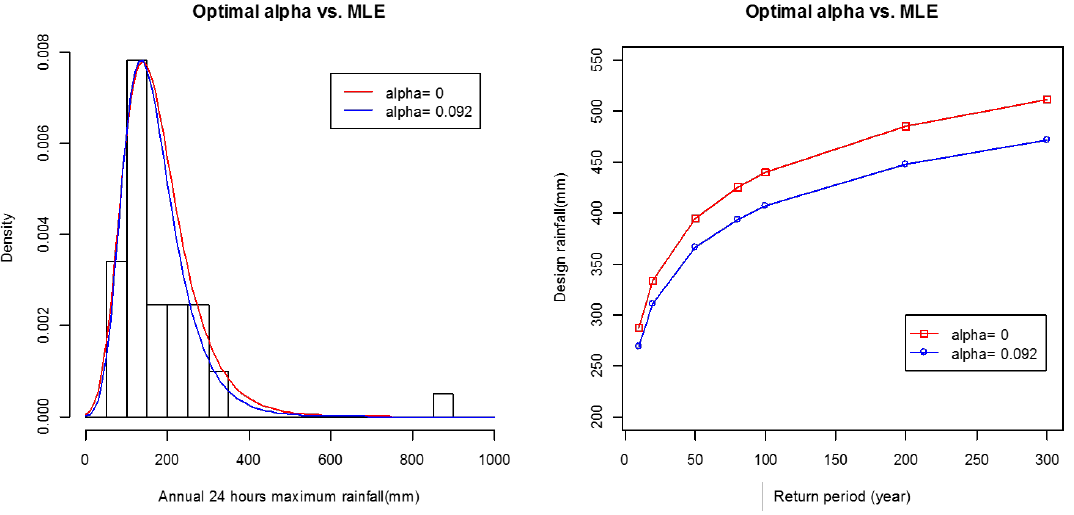
Figure 7. Gumbel distribution with the optimal tuning parameter ( α = 0.092) and the corresponding design rainfall depending on the return periods.